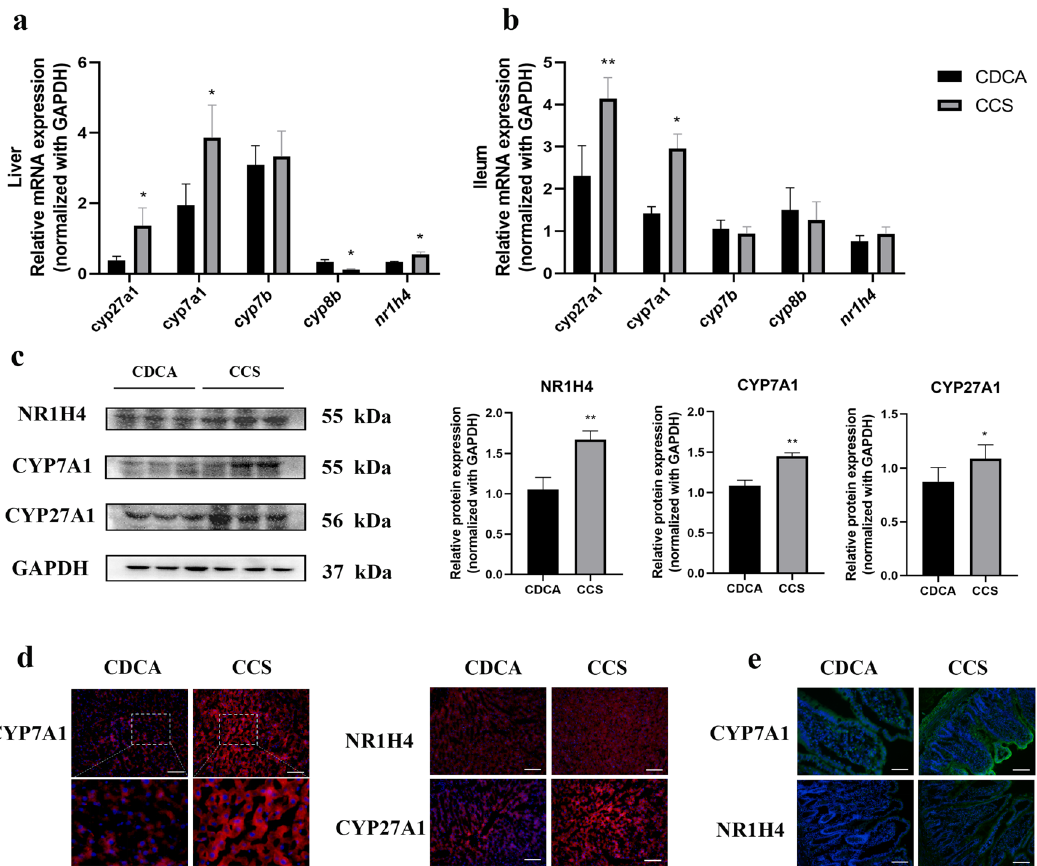
Fig. 7 CCS regulated BAs metabolism-related gene and protein expression levels in HFD-fed rats. a BAs metabolism-related gene expression in liver of rats; b BAs metabolism-related gene expression in ileum of rats; c BAs metabolism-related protein expressions in liver of rats; d immuno fl uorescence of pivotal protein expressions in liver of rats; e immuno fl uorescence of pivotal protein expressions in ileum of rats. Data are expressed as mean ± standard deviation. One-way ANOVA was used to analyze statistical differences; compared with control group, # P < 0.05, ## P < 0.01; compared with HFD group, * P < 0.05, ** P <